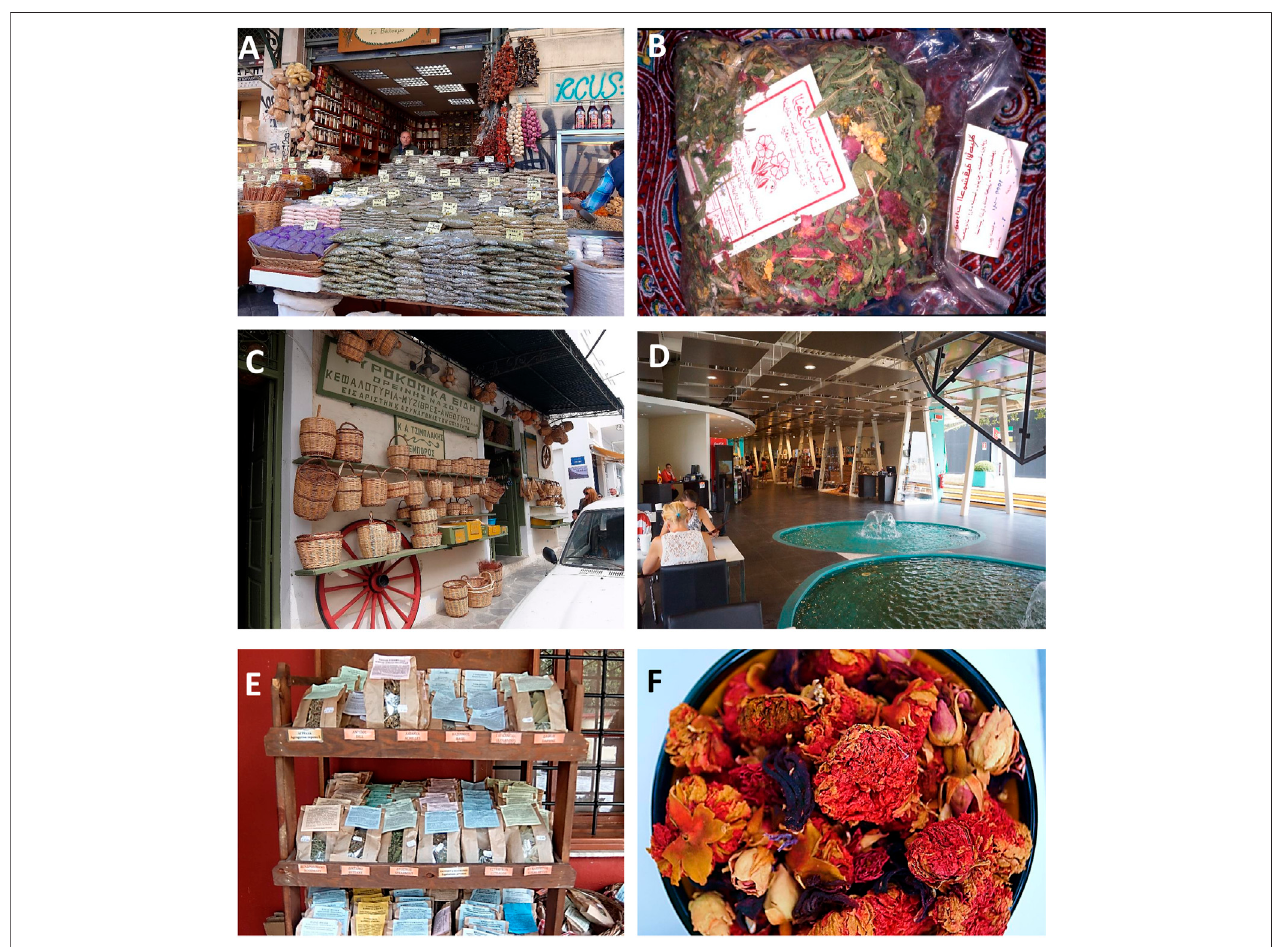
FIGURE 1 | Herbal teas with fl owers from Greece and the Eastern Mediterranean. (A) B αρβ ά κει o ς A c o ρ ά , Varvakeion Market in Athens, Herb Shop on Athinas Street; (B) “ Zhourat ” bag from the Damascus market; (C) Grocery store in Naxos on Sokratous Papavasiliou Street; (D) Shop with herbal teas of the Iranian Pavillion at Expo 2015, Milan; (E) Mixtures of medicinal plants from the monastery of Agios Dionisos (Lithohoro), located at the foot of Olympus; (F) Ottoman Style herbal tea with: carcade, Damask rose buds and pomegranate fl owers. Photos: C. Obón and D. Rivera.